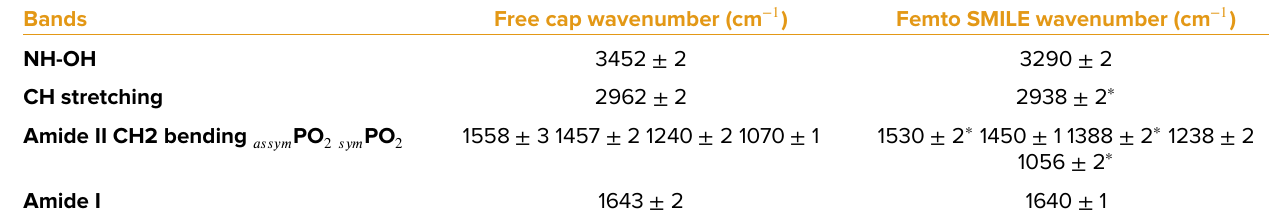
Table 2. Wavenumber (cm −1 ) for FTIR spectra bands for free cap and Femto SMILE laser groups, in the NH-OH, CH stretching, Fingerprint and Amide I regions.